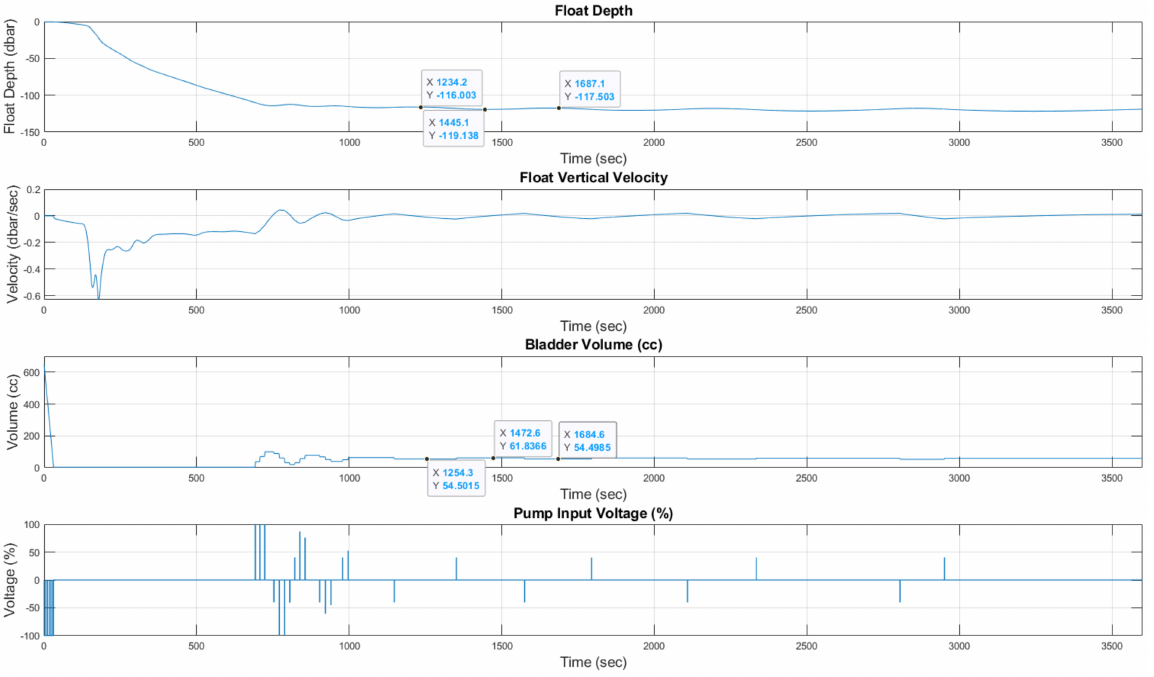
Figure 13. Simulink motion simulation